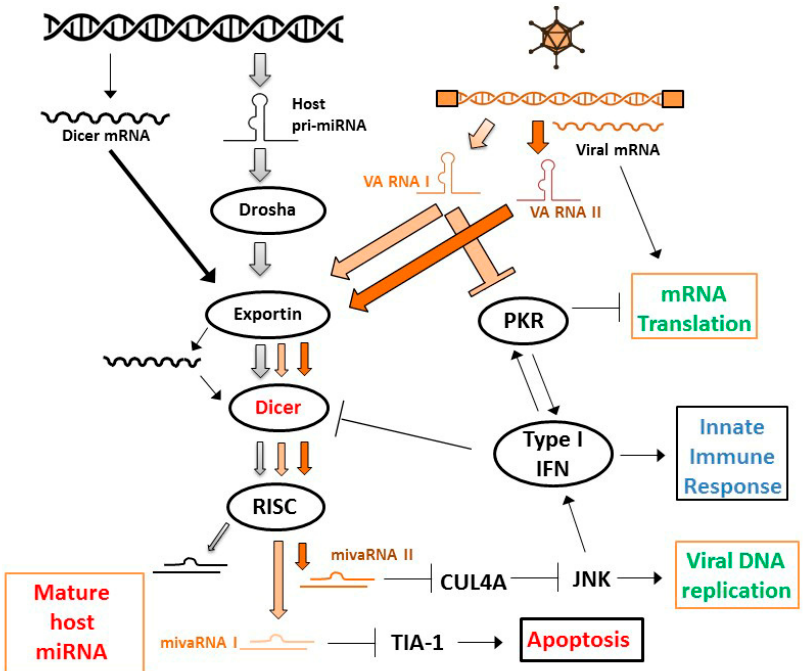
Figure 2. Interaction between adenovirus-encoded small RNA molecules and the host cell RNAi machinery and interferon–double-stranded RNA-activated kinase (PKR) response in the late phase of infection. Virus-associated (VA) RNAs I and II inhibit endogenous miRNA processing via competition at several levels in the RNAi machinery, as well as by reducing Dicer messenger RNA (mRNA) nuclear export. Upon processing of VA RNAs into viral miRNAs (mivaRNAs), they silence cellular mRNAs to inhibit apoptosis and promote viral DNA replication. VA RNA I directly inhibits PKR to promote (viral) mRNA translation and, thus, protein expression for capsid production. Regulation of type I interferons evoking innate immune responses is complex, with on one hand mivaRNA II-mediated stimulation and on the other hand VA RNA I-mediated inhibition of PKR-dependent stimulation. The type I interferon response inhibits Dicer function, contributing to inhibition of miRNA processing. Colors illustrate the different effects in cells in the late phase of infection: red, inhibited; green, stimulated; blue, complex regulation; orange, virus-encoded and virus-related; black, cellular.